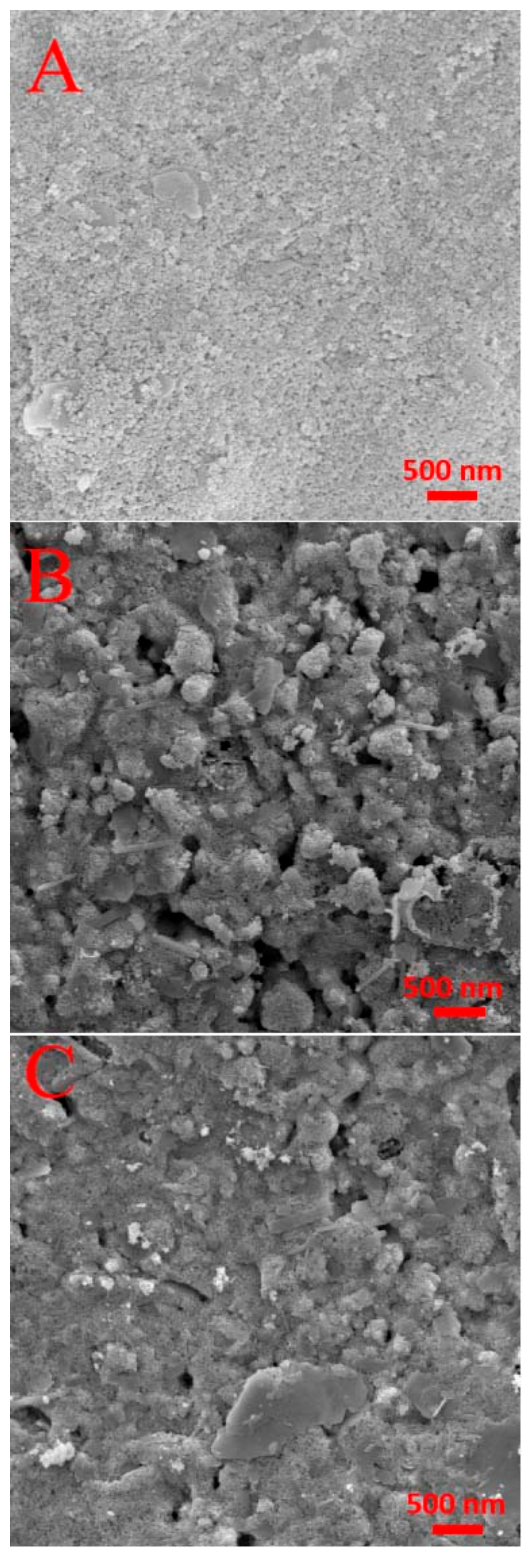
Figure 4. The SEM images for honeycomb catalysts produced by different titanium sources: ( A ) filter cake, ( B ) titanium dioxide, and ( C ) filter cake plus titanium dioxide.